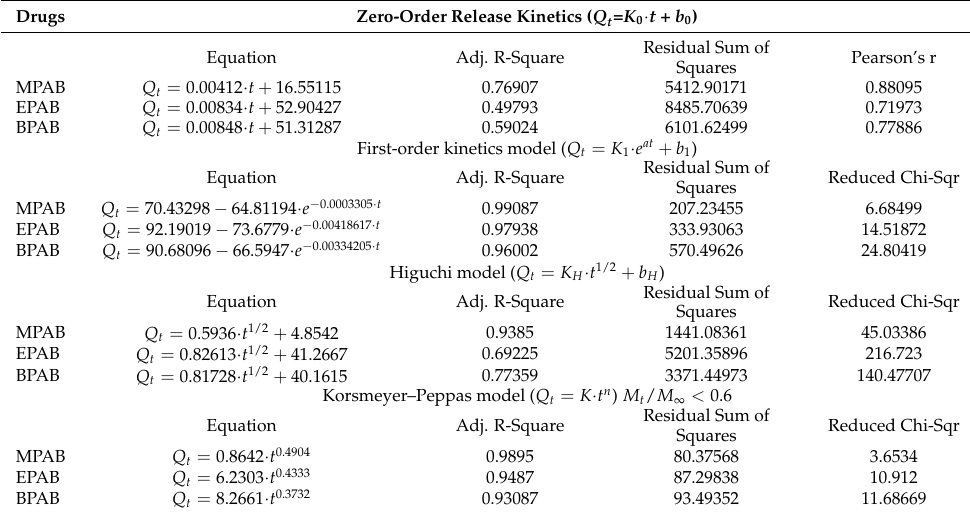
Table 2. The release kinetics model fitting parameters of MPAB, EPAB, and BPAB